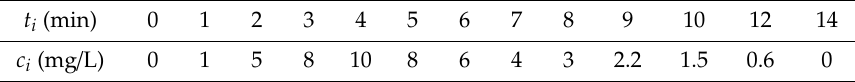
Table 1. The results of a tracer test carried out on this reactor.